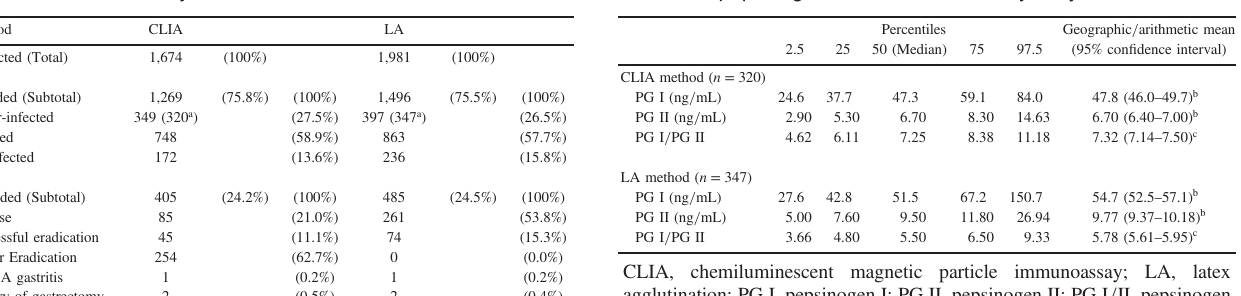
Table 3. Percentiles and geographic / arithmetic means for